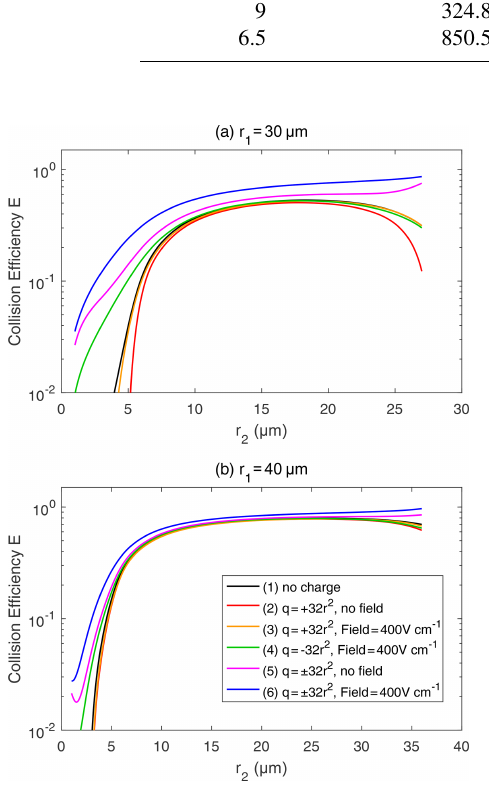
Figure 7. Collision efficiency for droplets with electric charge and field. The radius of the collector droplet r 1 is (a) 30.0µm and (b) 40.0µm. The x axis denotes the collected droplet radius r 2 . The two droplets carry electric charges proportional to r 2 . In both panels, line (1) for droplet pairs with no charge is the same as the 30 and 40µm lines in Fig. 6. In line (1), the setting of the electric charge and field is no charge and no field. Line (2) shows q 1 = + 32 r 12 and q 2 = + 32 r 2 2 , with no field. Line (3) shows q 1 = + 32 r 1 2 and q 2 = 2 , with a downward electric field of 400Vcm − 1 . Line (4) + 32 r 2 shows q 1 = − 32 r 1 2 and q 2 = − 32 r 2 2 , with a downward electric field of 400Vcm − 1 . Line (5) shows q 1 = + 32 r 1 2 and q 2 = − 32 r 2 2 , with no field. Line (6) shows q 1 = + 32 r 12 and q 2 = − 32 r 22 , with a downward electric field of 400Vcm − 1 .